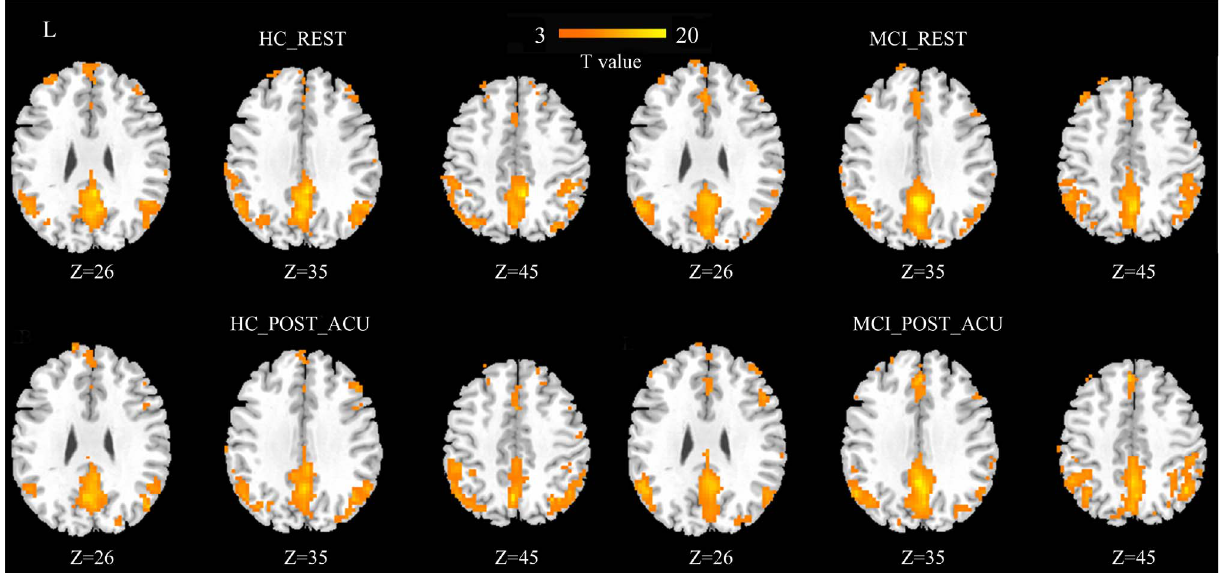
Figure 3. Results of regional homogeneity (ReHo) shown as a Kendall’s coefficient of concordance (KCC) map across all subjects for MCI patients and healthy controls during resting state and post-acupuncture resting state (p , 0.05, FDR